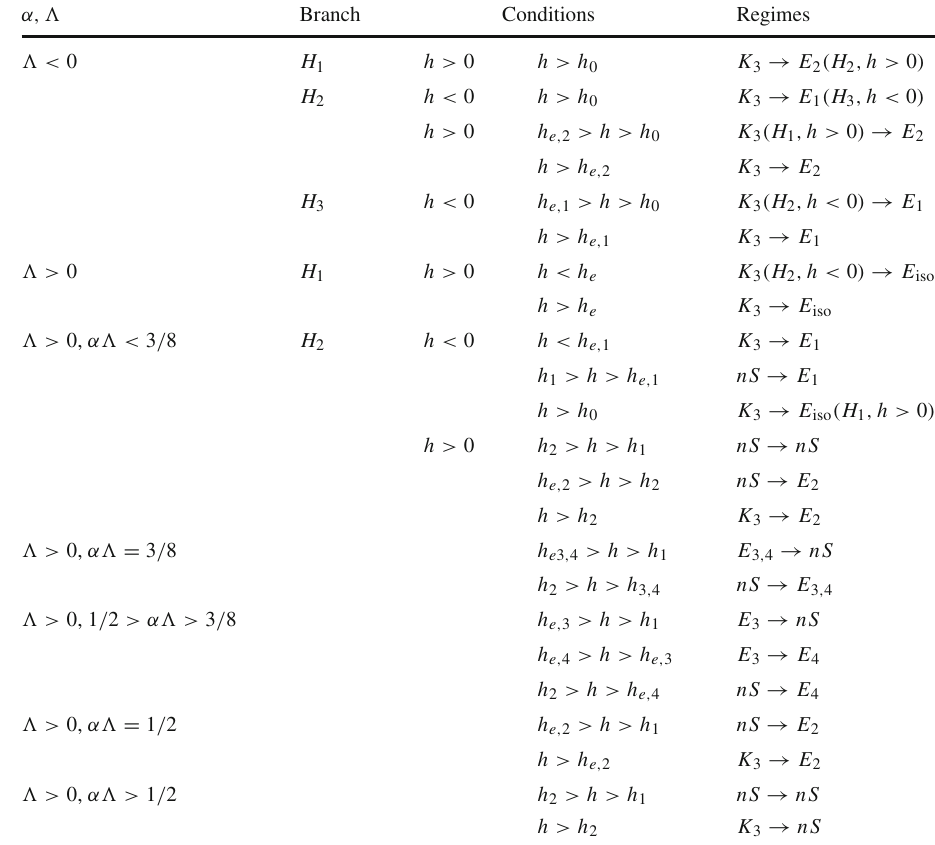
Table 3 Summary of nontrivial D = 3 α > 0 (cid:2) -term